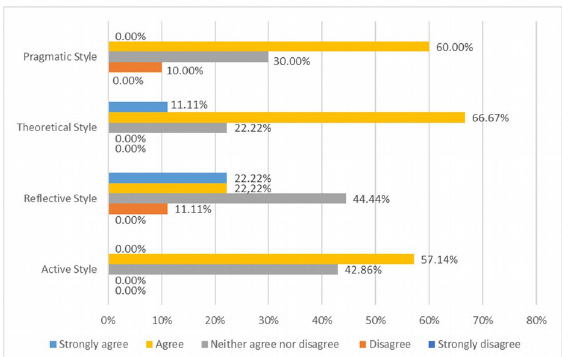
Figure 3. My interactions with the teacher during class are more frequent and positive